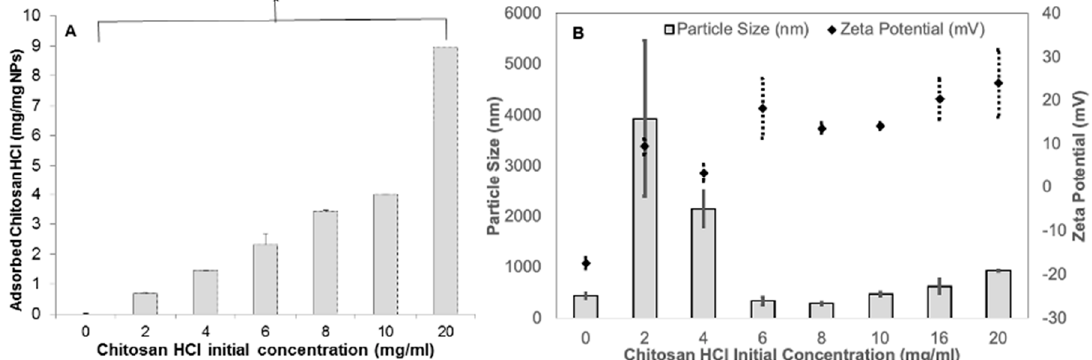
Figure 1. The relationship of CHL concentration to the amount absorbed on PGA-co-PDL NPs ( A ). Zeta potential and particle size of hybrid cationic CHL NPs ( B ) ( n = 3, p < 0.05 is indicated by *).